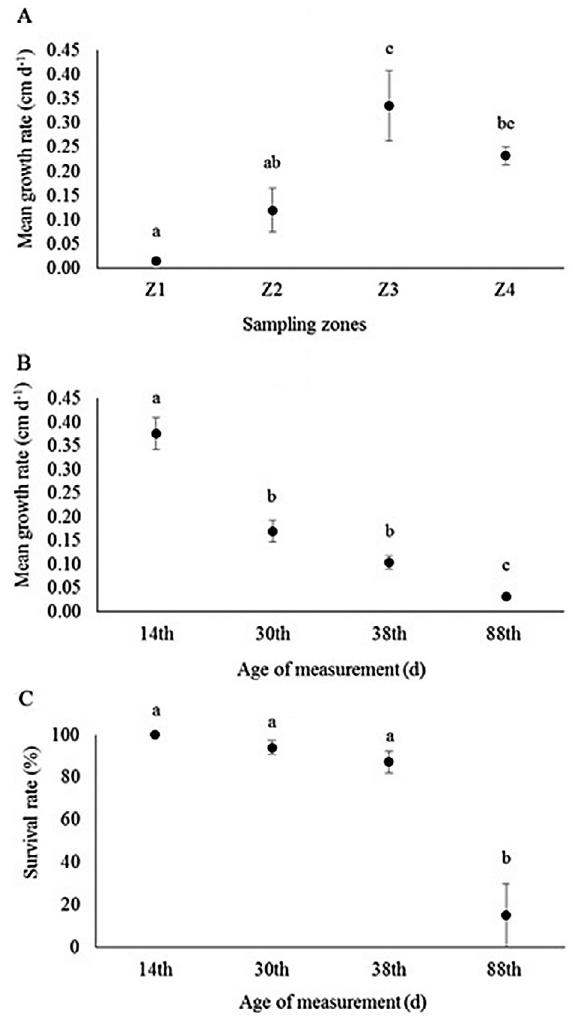
Fig. 2. – A, mean growth rate (cm/d) of Avicennia marina seedlings from four zones: Z1 (n=7), Z2 (n=6), Z3 (n=4) and Z4 (n=24); B, mean growth rate ± SE (cm d –1 ) of Avicennia marina seedlings at Zone 4 days 14 (n=25), 30 (n=25) 38 (n=24) of sampling; C, mean survival rate (%) of mangrove seedlings between sampling periods and zones. Different letters indicate significant difference and overlapping letters indicate no significant difference (p<0.05; Tukey test).